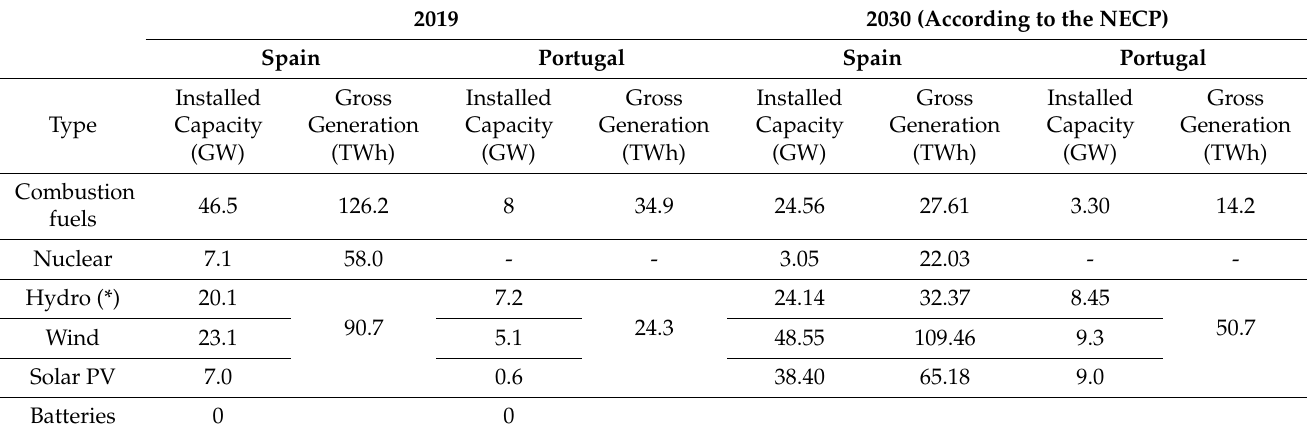
Table 1. Generation mix in the Iberian Peninsula - Data from References [33–35].